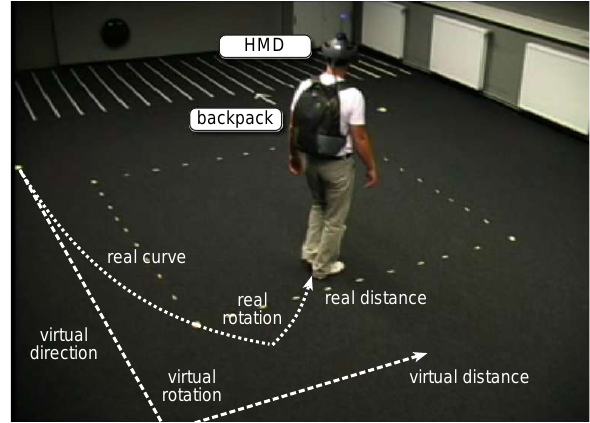
Fig. 1. Redirected walking scenario: a user walks in the real environment on a different path with a different length in comparison to the perceptual path in the virtual